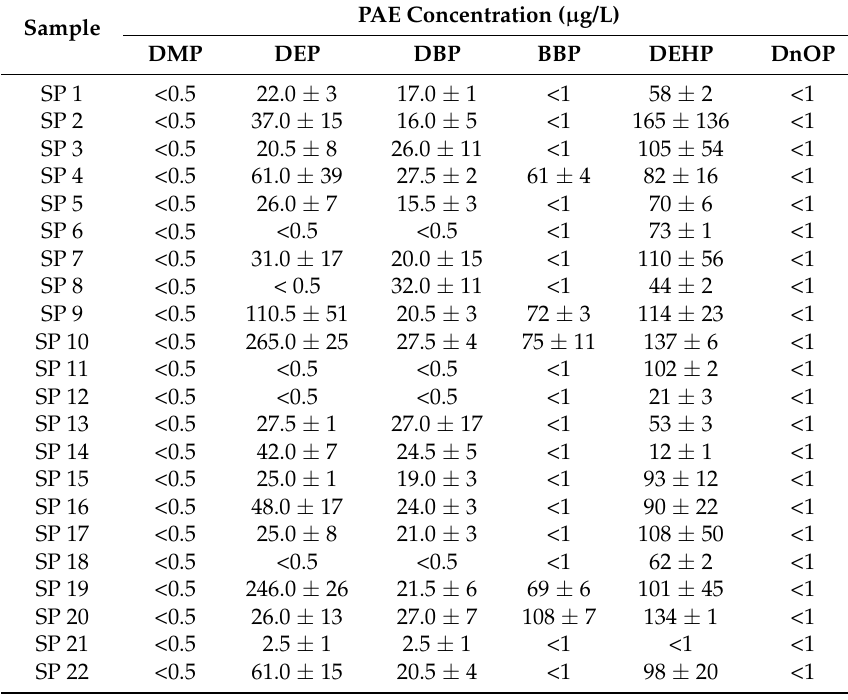
Table 3. PAE concentrations in water at sampling locations.